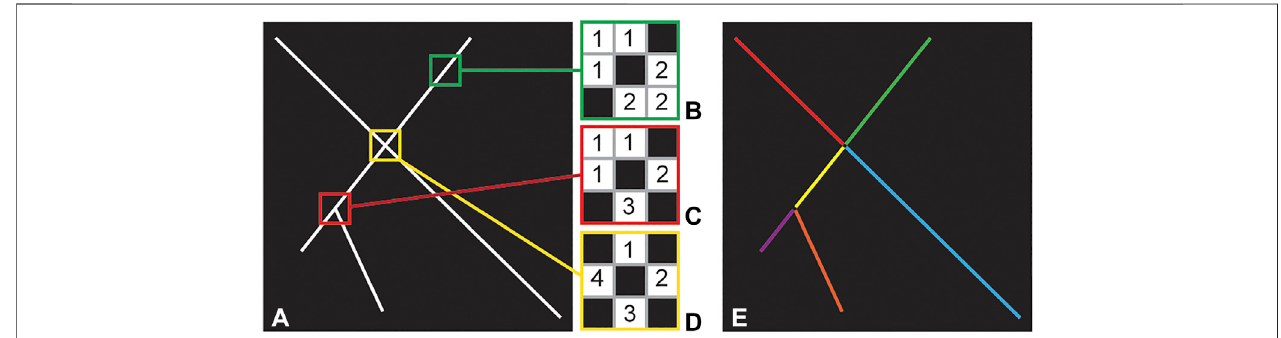
FIGURE 4 | Hypothetical 2D slice of 3 intersected lines (A) . (B – D) 3 × 3 windows centered at different positions exhibit the number of labeled regions that can surround a central FTP. This is 2 in the case of a single linear feature (B) ; 3 around bifurcating segments (C) ; and 4 in the case of two cross-cutting lines (D) . If 3 or more regions are measured, the one-value pixels, i.e., the fracture intersection, are removed, and the image is divided in fractures segments labeled with different values (as shown by the different colors in (E) ).